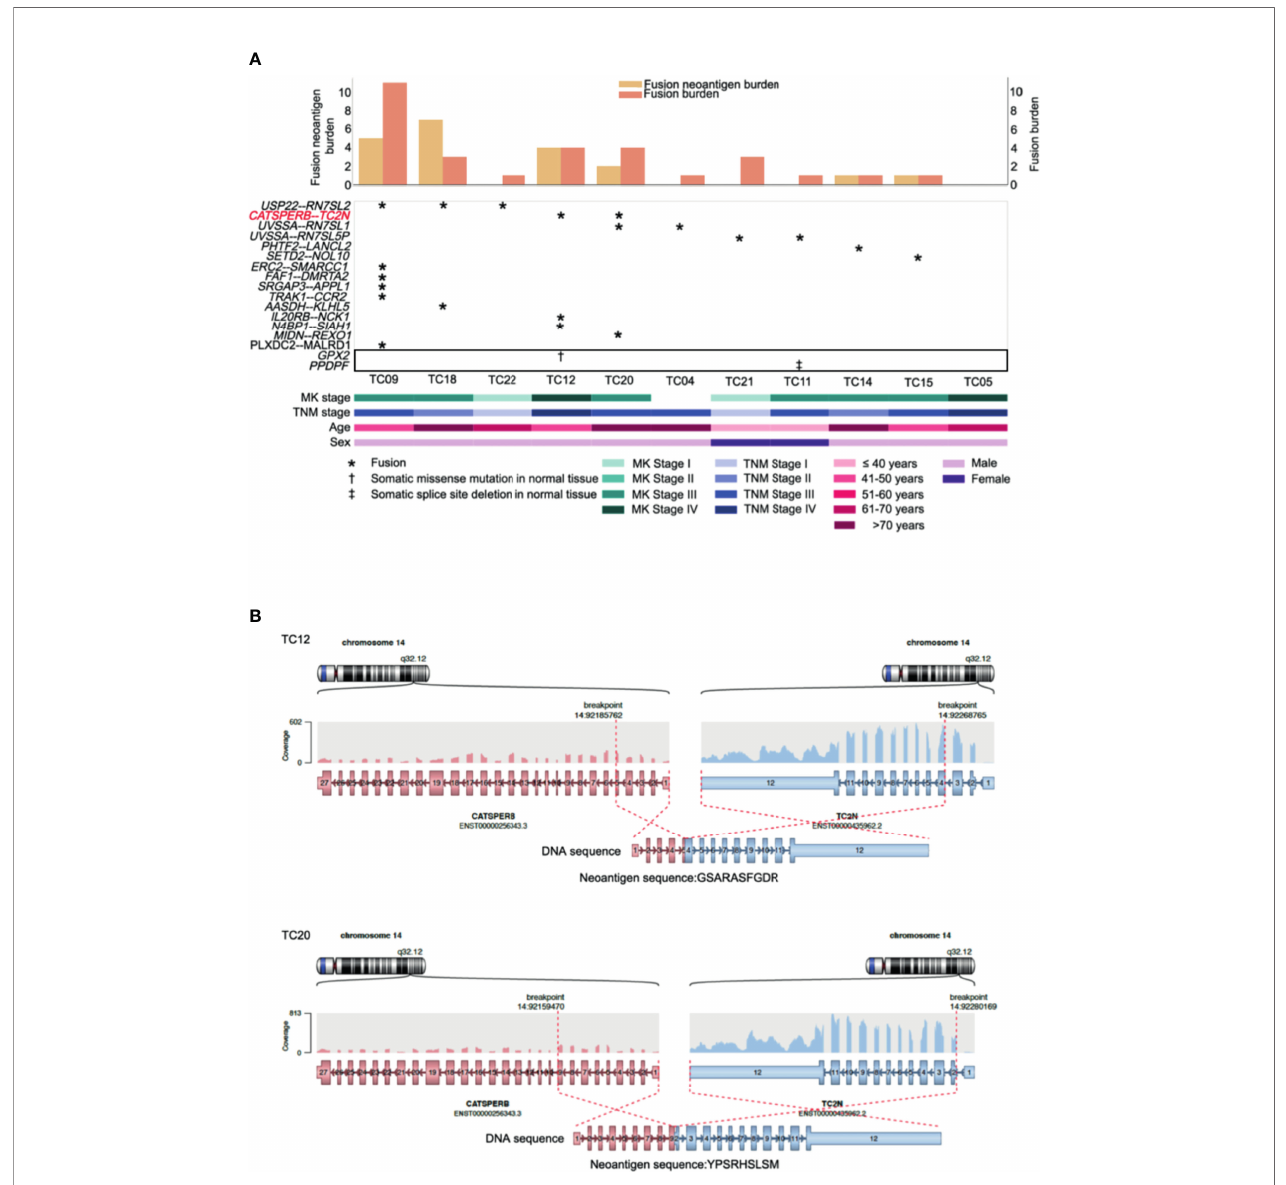
FIGURE 3 | Repertoire of genes with neoantigens and somatic alterations in adjacent normal tissues of thymic carcinoma patients (n = 11). (A) CoMut plot for each patient (column). Top: left y-axis for fusion neoantigen burden, i.e., total number of predicted neoantigens; right y-axis for fusion burden, i.e., total number of fusions. Middle: Row represents predicted fusions and somatic alterations in the adjacent normal tissues (indicated in the box) of thymic carcinoma patients. Symbols indicate the types of alterations. Bottom: Clinical characteristics of thymic carcinoma patients. MK stage: Masaoka Koga stage. (B) The predicted CATSPERB-TC2N fusion-derived neoantigens in patients TC12 and TC20. Each plot depicts the fusion partners, their orientation, and the retained exons, with corresponding neoantigen sequences annotated below the fusion